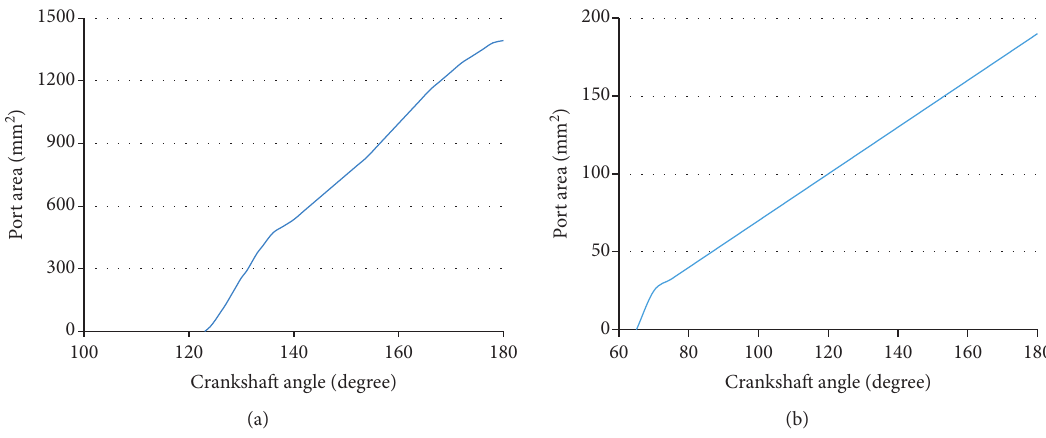
Figure 4: Working process of the two-stroke aeroengine. (a) Intake port area. (b) Exhaust port area.